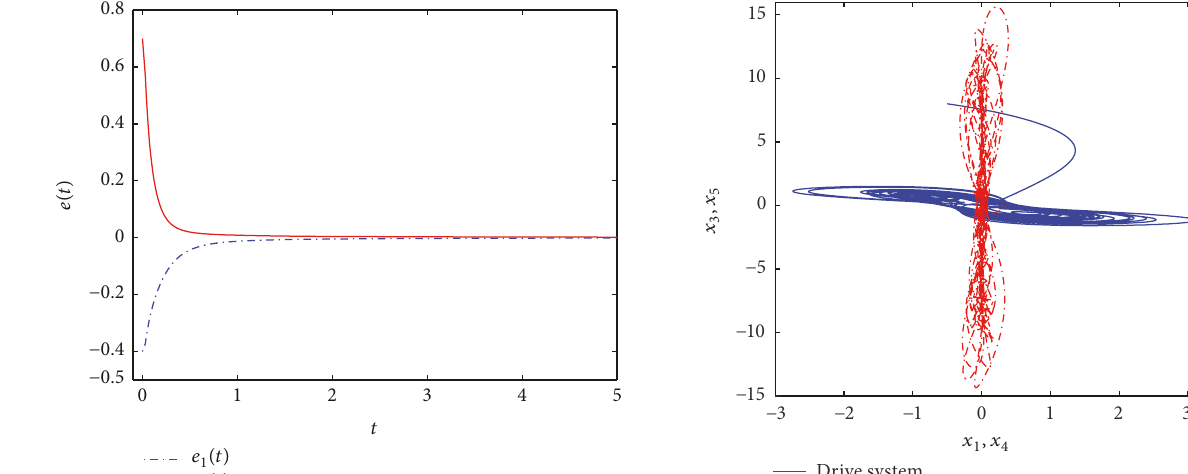
(𝑡) = 0.1 cos (2𝑡) and ℎ 1